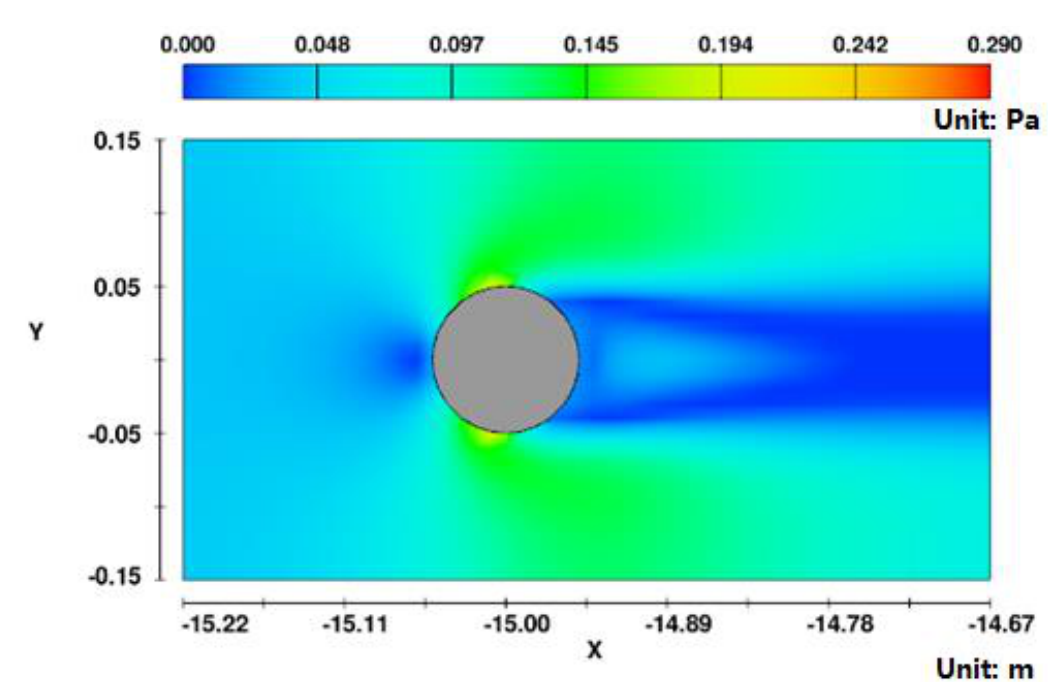
Figure 10. Excess shear stress distribution (0.05 m above the seabed) of Case 4.